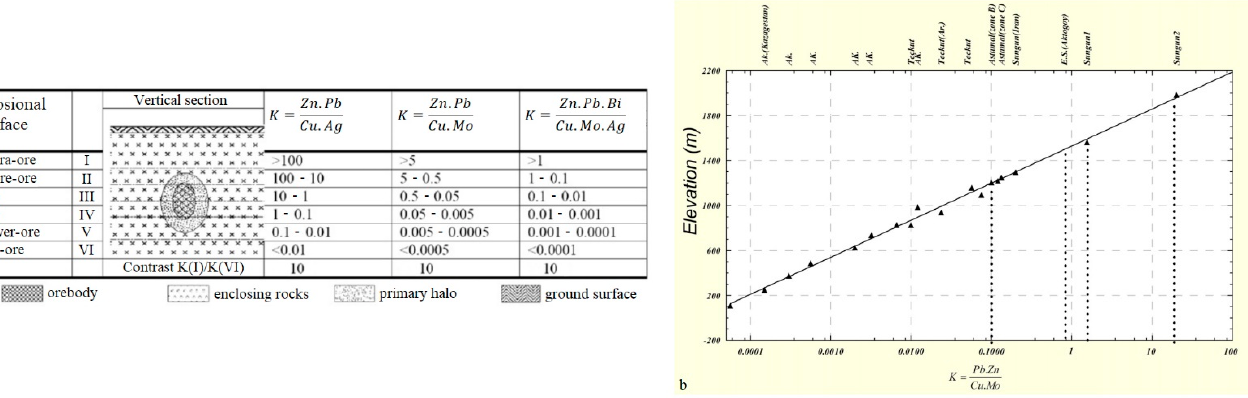
Table 2. Areal productivity, mineralization coefficient, and zonality index introduced by Solovov and zonality index introduced by Grigorian for Cu, Mo, Pb, and Zn elements in zones I and II. Zone